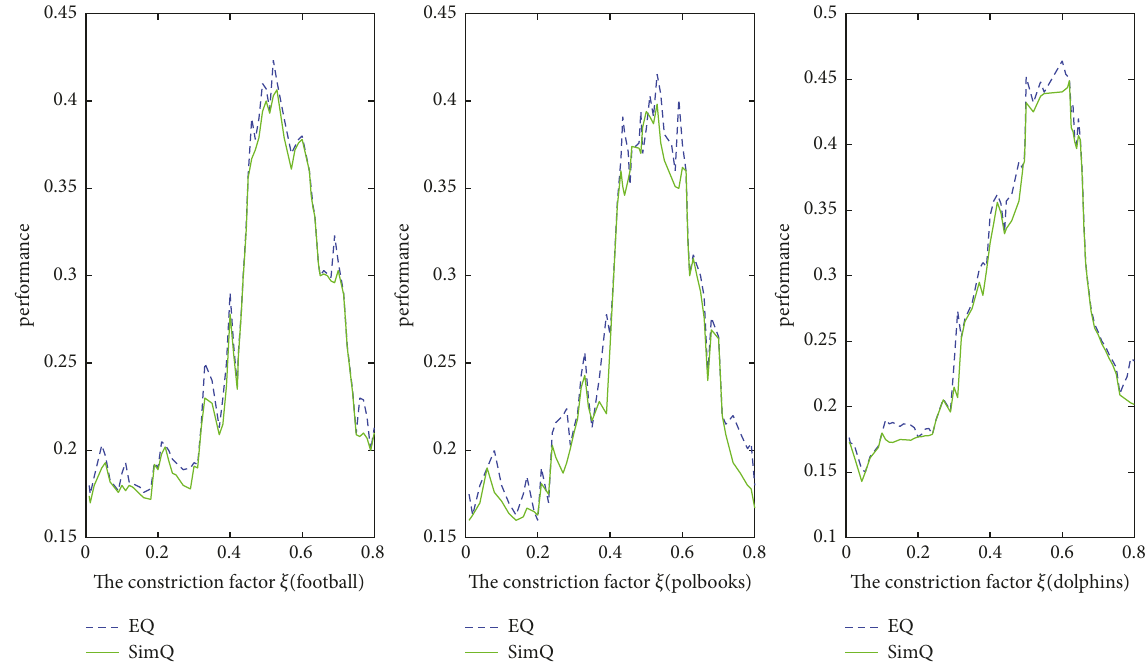
Figure 9: The digrams of comparison on the constriction factor with 𝐸𝑄 and 𝑆𝑖𝑚𝑄 .